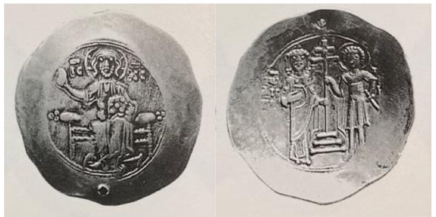
Figure 7. Aspron Trachy Nomisma , 1118–1143; impression on electrum; Dumbarton Oaks, Washington D.C.; 8b.2 Schindler 1960 (Kallai i.33). Published at [15] (Ibid, pp. 261–274. The issues from the mint at Thessalonike have St Demetrios, the patron saint of the city, while those from Constantinople have St George. Images on Plates VIII and